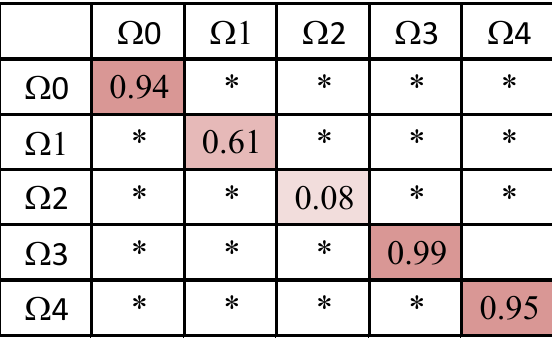
Figure 3. Confusion matrix for α = GAU_0.7 and β = UP_1.5.